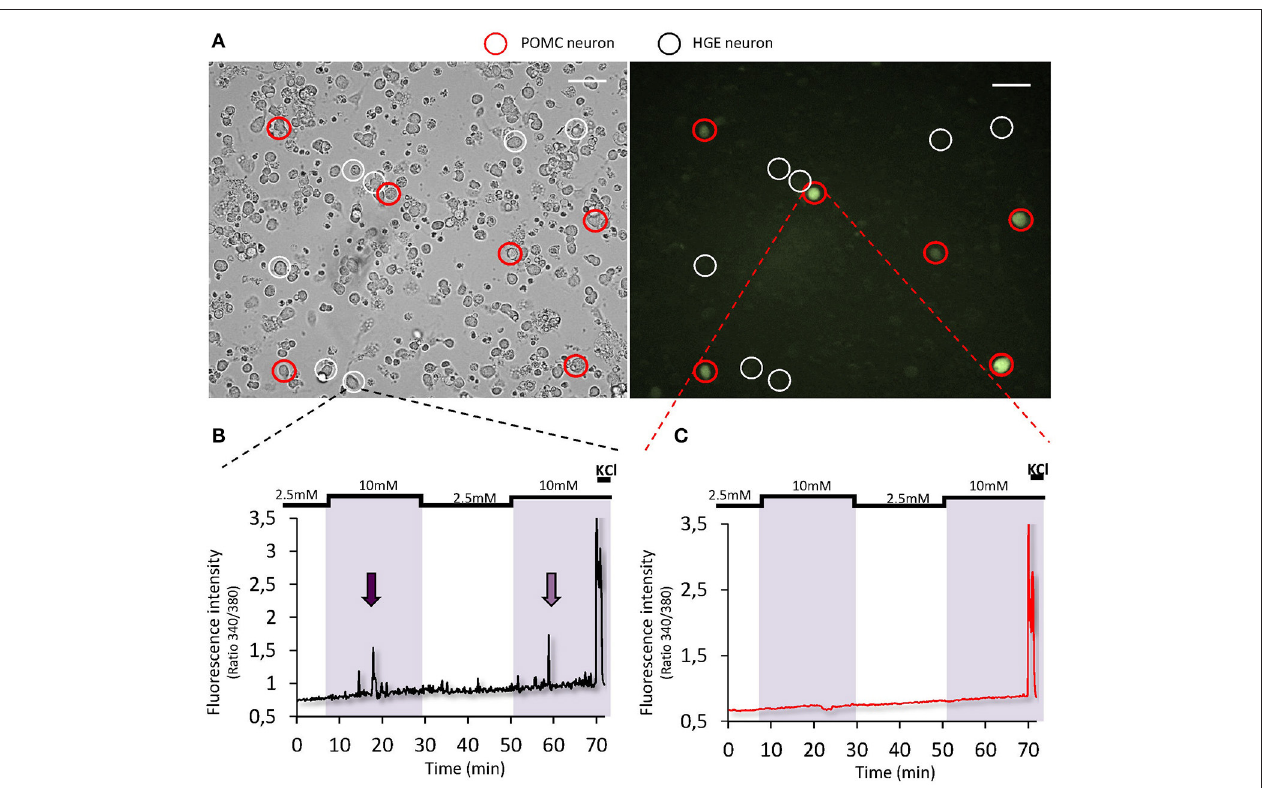
FIGURE 2 | Glucose-sensing properties of POMC neurons. (A) Representative bright-field (left panel) or fluorescence (right panel) images of cultured dissociated MBH neurons from POMC-GFP mice ( × 20 objective, scale bar = 40 µ m; Fioramonti et al., 2007). Detailed methods for cell culture preparation and calcium imaging recording is explained in Chretien et al. (2017). (B,C) Representative calcium imaging traces of a HGE (B) or a non-glucose-sensing POMC neuron (C) in response to 2 consecutives increased glucose level from 2.5 to